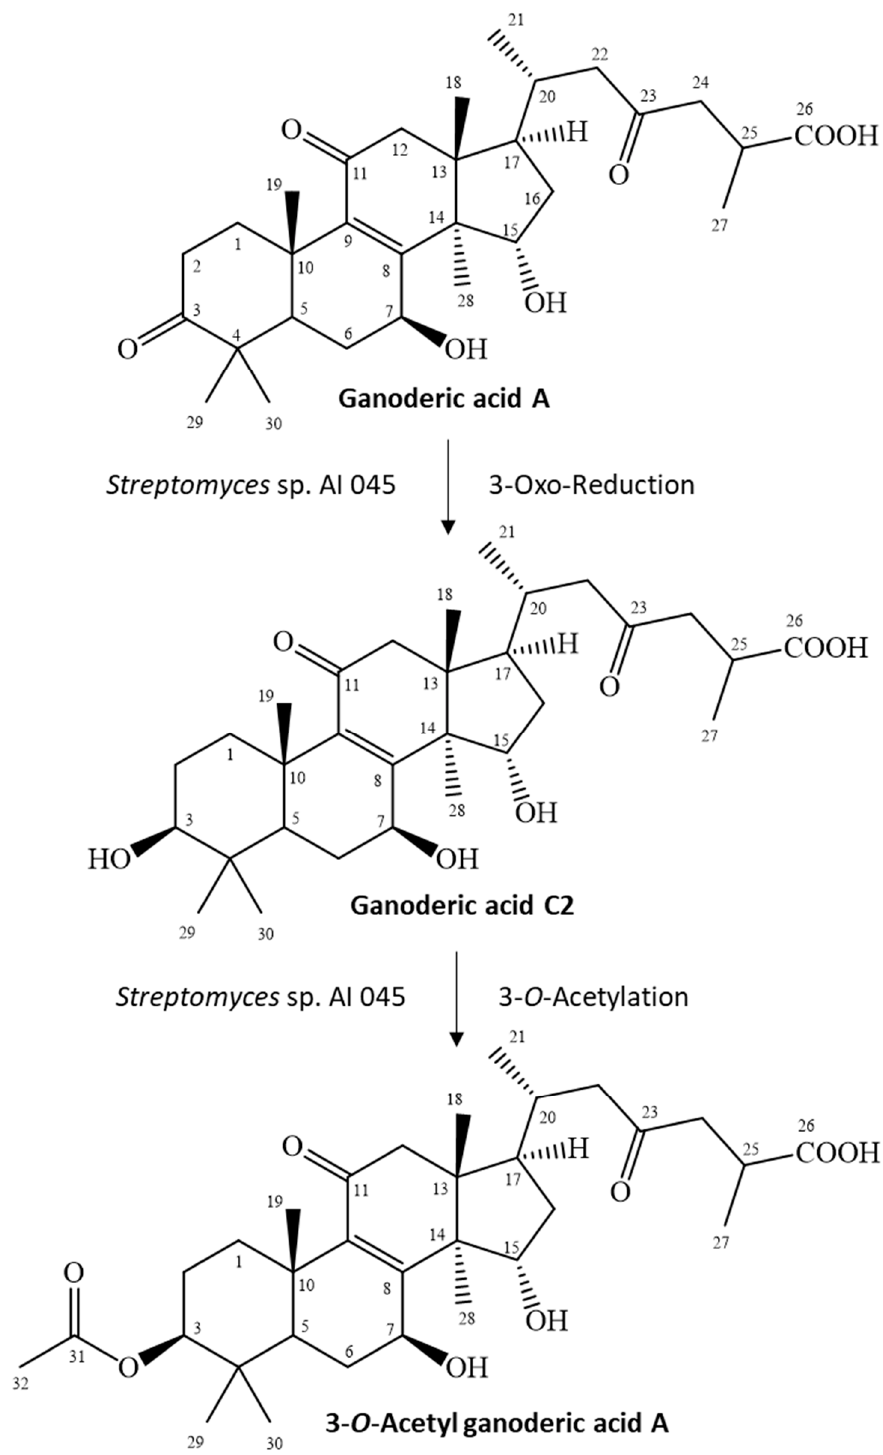
Figure 3. Proposed biotransformation process of ganoderic acid A by the Streptomyces sp. AI 045